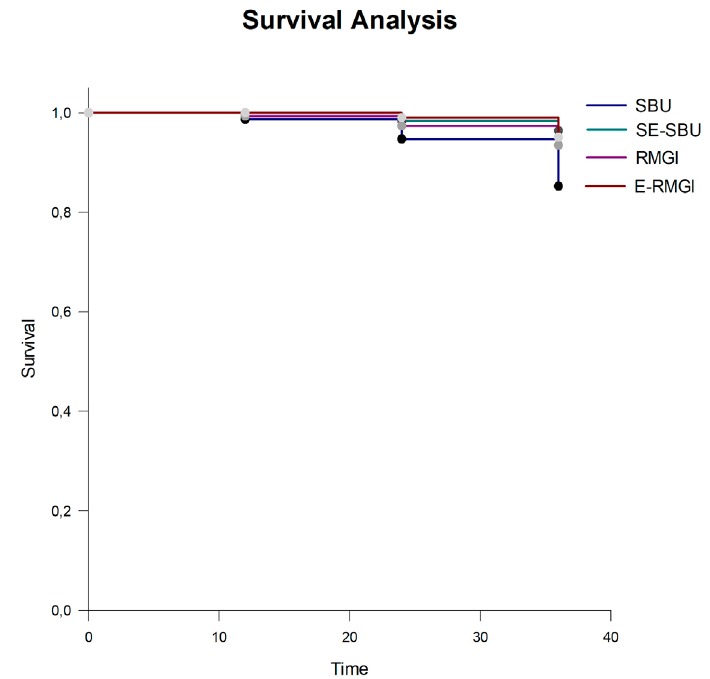
Figure 2- Retention survival comparison among the four groups